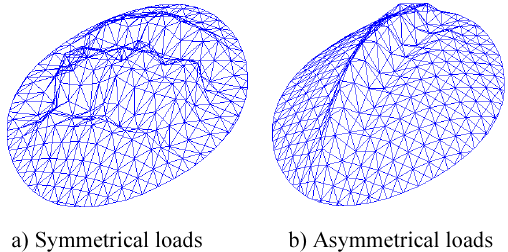
Fig. 8. Deformed shape of the hybrid grid shell in geometrical non-linear